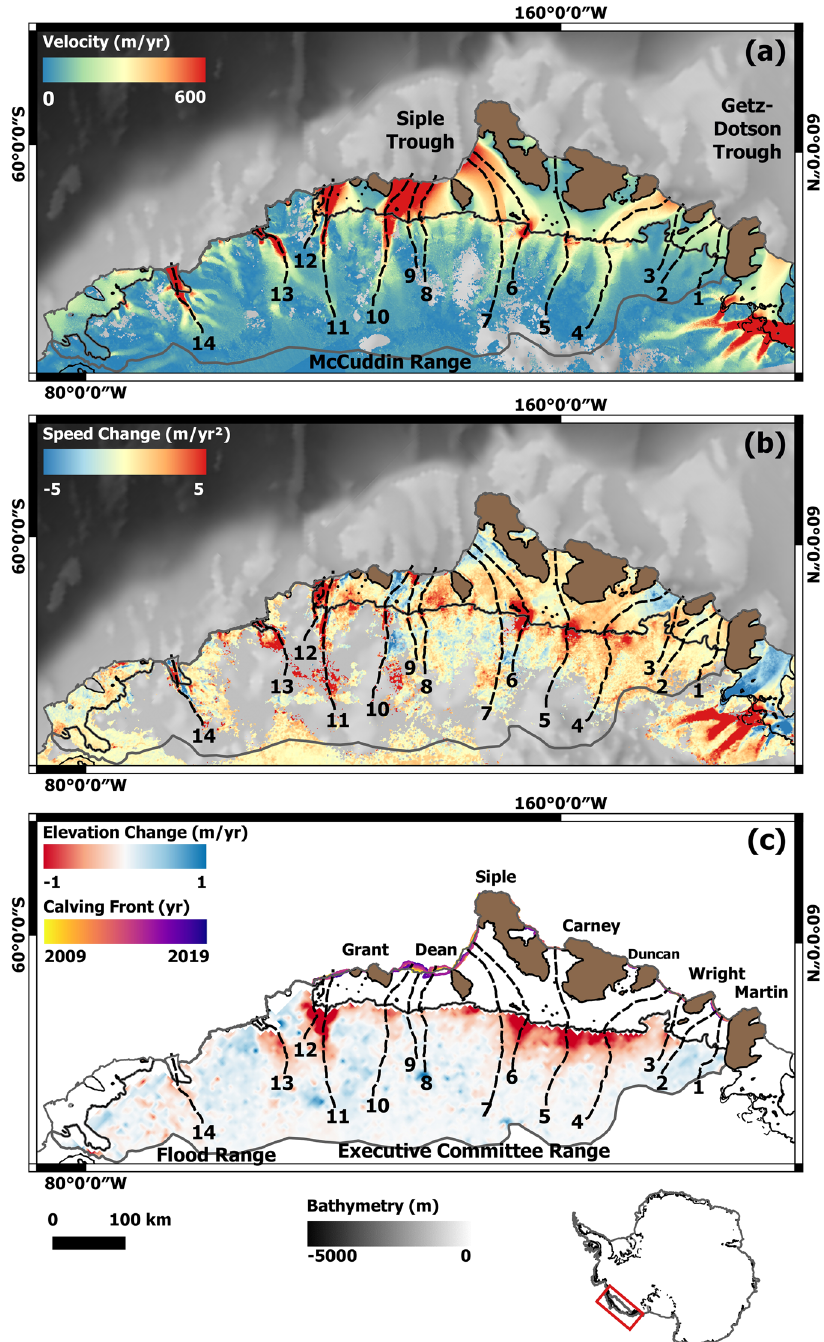
Fig. 1 Ice speed, speed change and thinning over the Getz basin. a Ice speed in the Getz drainage basin of Marie Byrd Land, measured in 2018 using Interferometric Wide (IW) mode synthetic aperture radar (SAR) data acquired by the Sentinel-1a/b satellites. The grounding line location (solid black line 67 ), inland limit of the drainage basin (solid grey line) and the location of 14 fl ow line pro fi les (dashed black lines) are also shown. Pro fi les 1 to 9 are located on unnamed glaciers; however, 10 to 14 correspond to DeVicq, Berry, Venzke, Hull and Land Glaciers, respectively. Measurements are superimposed on BEDMAP2 bedrock topography 32 . b A map of the observed rate of change in ice speed between 1994 and 2018. c Ice sheet elevation change with Firn Densi fi cation Model (FDM) correction applied from 1992 to 2017, measured using satellite radar altimetry data 8 . The names of islands and ice rises (brown area) bordering the Getz Ice Shelf are also indicated. The calving front location is shown from 2009 in yellow to 2019 in purple, see Supplementary Fig. 7 for a zoom of the calving front